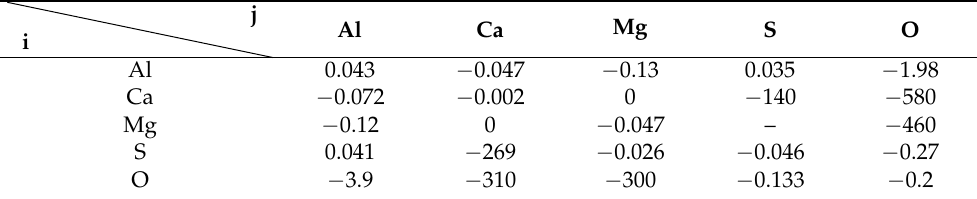
Table 4. The first Interaction coefficient in the present study. Data from [25–34].